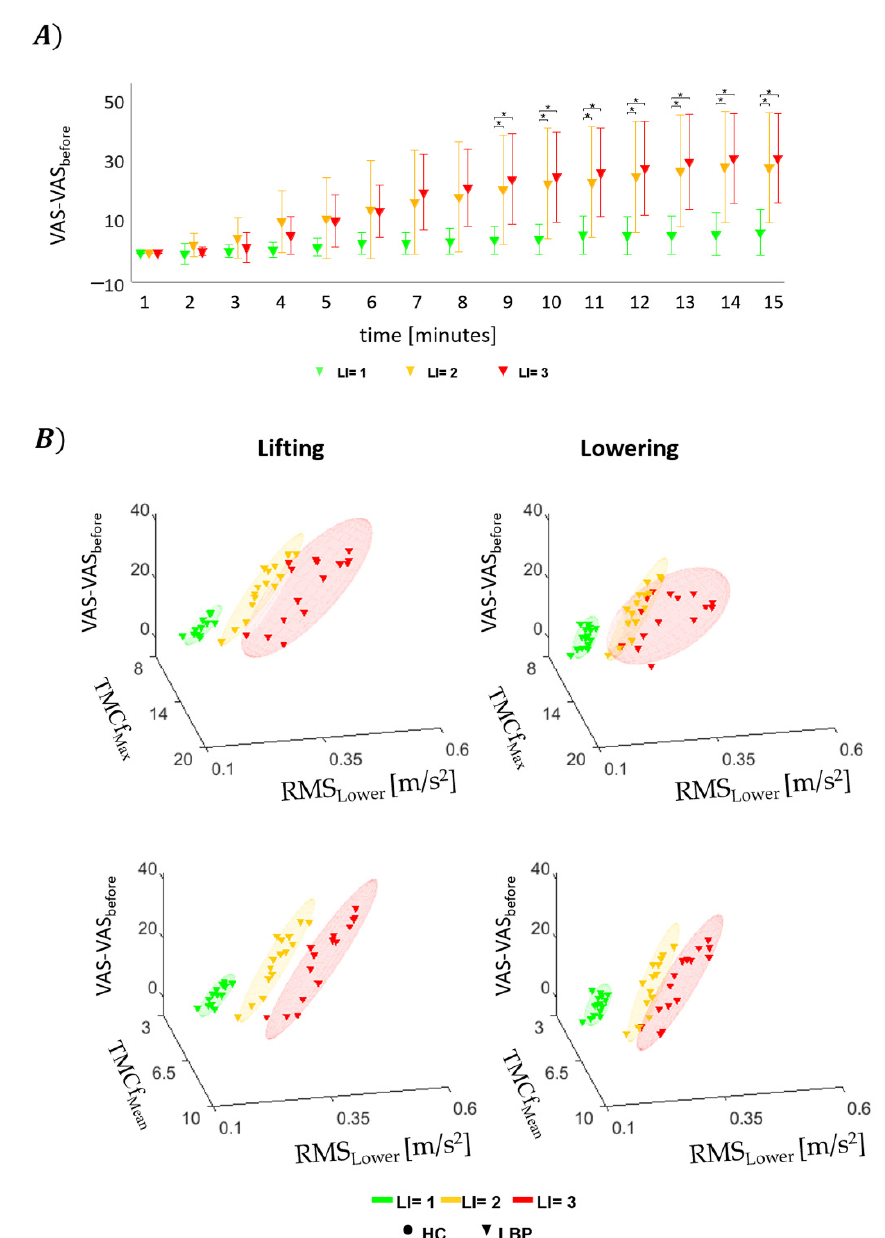
Figure 7. Mean values ± SD in each minute of VAS for pain intensity normalized to the values before starting the lifting ( A ). Plot 3D ( B ) with mean for each risk level in for the VAS, the max (TMCf Max ) and mean (TMCf Mean ) values of TMCf function and the RMS of the acceleration of lower trunk (RMS lower ) considering all repetitions within each minute of lifting and lowering cycles. [* statistical significance ( p < 0.05)].